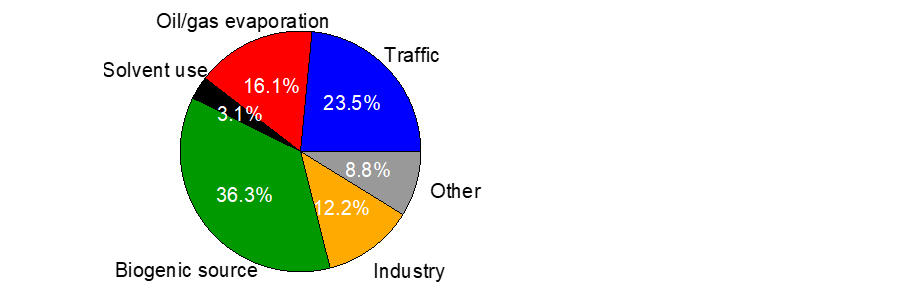
Figure 10. Relative contributions of the PMF-resolved sources to the TVOC NCR.